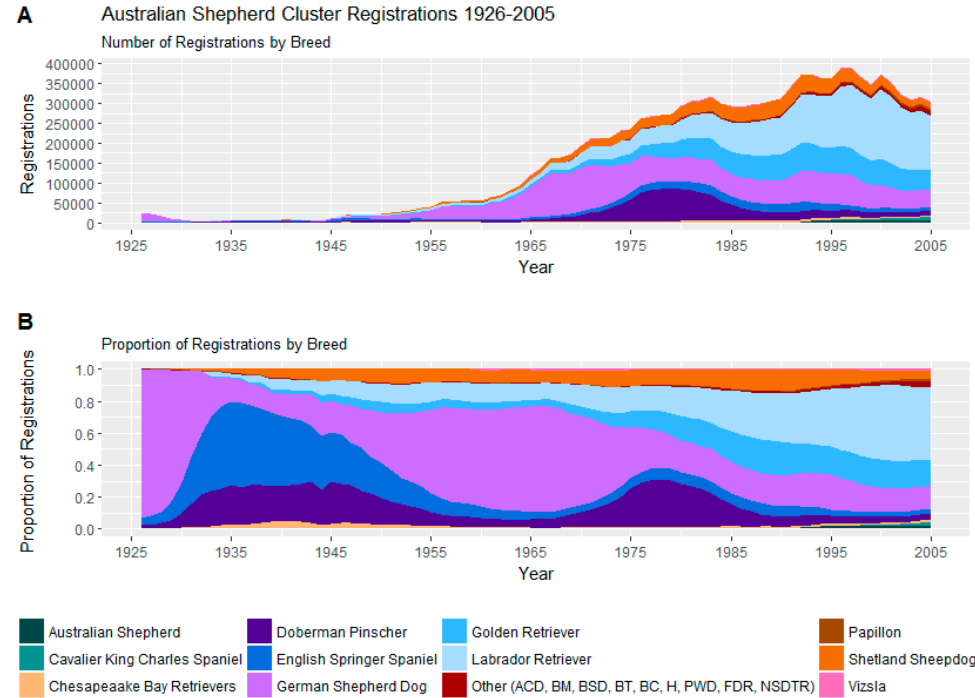
Figure 8. ( A ) Number of registrations; ( B ) and proportion of registrations within the Australian Shepherd cluster.